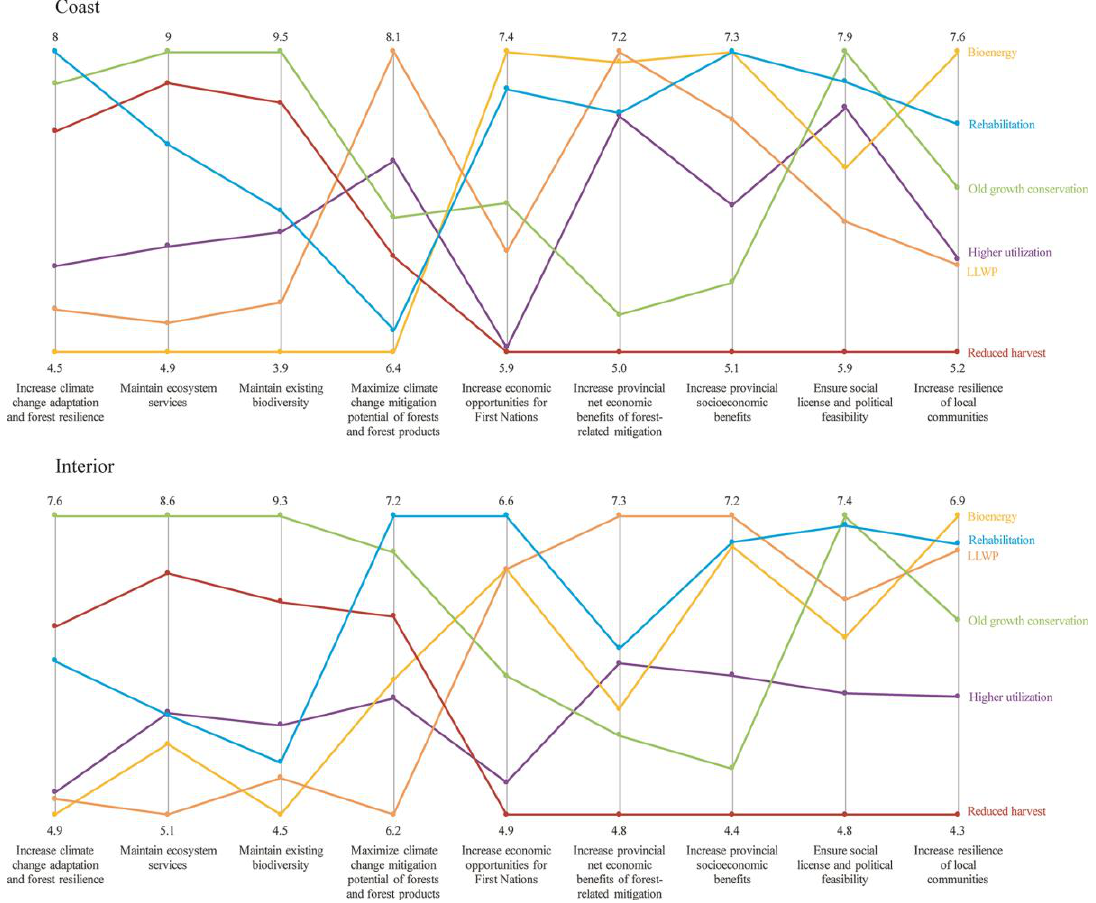
Figure 6. Average score of the six strategies on performance against each of the nine objectives for the coast (Nanaimo and Vancouver) and the interior (Kamloops and Prince George). The values are normalized (from 0 to 1) from the average score (from 0 = very poor to 10 = very good), with each vertical axis representing the scores of the strategies against one objective. The minimum and maximum average scores (out of 10) across scenarios are also shown in numbers at the top and bottom of the graph.